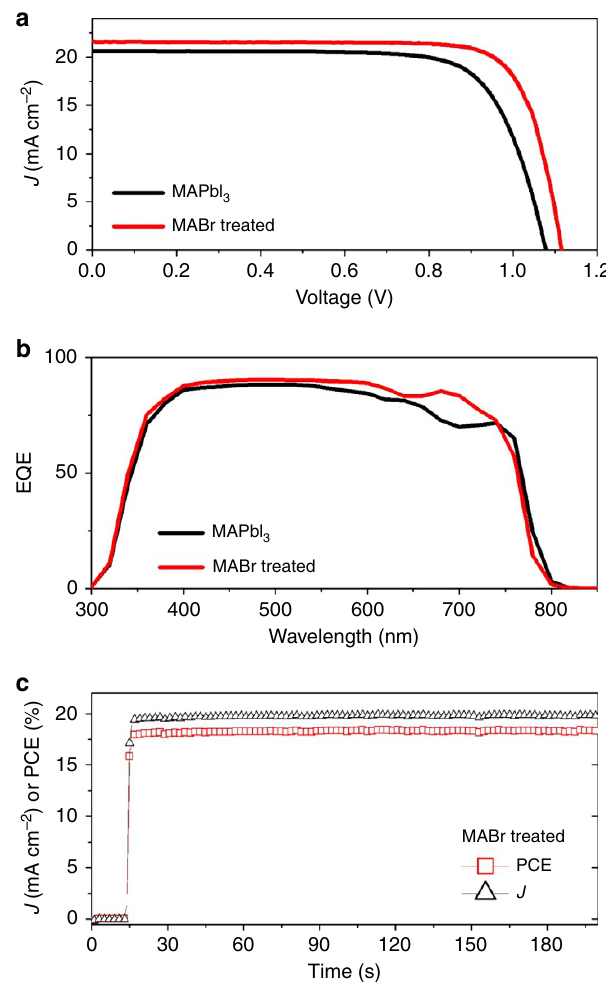
Figure 5 | Device characteristics based on high-quality pinhole-free MAPbI 3 thin films with and without MABr treatment. ( a ) J–V curves, ( b ) EQE spectra and ( c ) stabilized photocurrent density and power conversion efficiency biased near the maximum power point. MABr (2mgml (cid:2) 1 ) solution was used for the MABr treatment. Table 2 | MABr concentration effect on the typical photovoltaic parameters. MABr concentration (mgml (cid:2) 1